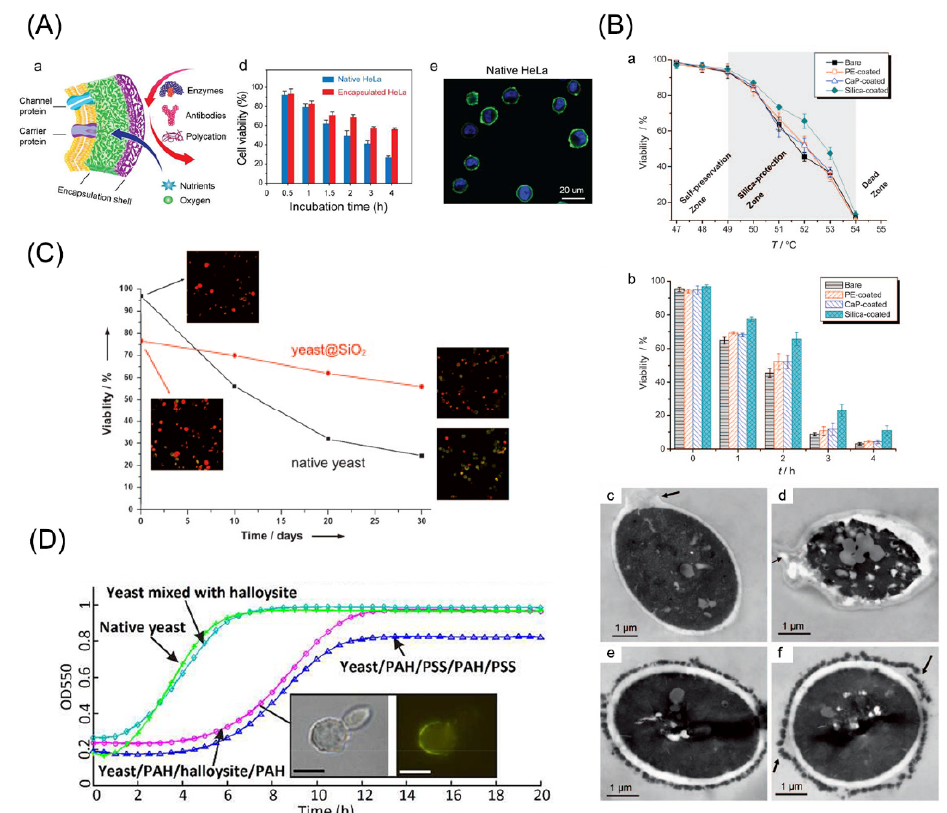
Figure 4. Functional regulation by cell encapsulation. ( A ) Yeasts can be protected from enzymes by encapsulation with gelatin and PEG. Adapted with permission [171]. Copyright 2017, Elsevier. ( B ) Thermo-resistance imposed by cell encapsulation. Adapted with permission [173]. Copyright 2010, John Wiley and Sons. ( C ) Encapsulated cells exhibited higher viability in water for a long term. Adapted with permission [174]. Copyright 2009, John Wiley and Sons. ( D ) Proliferation of yeast cells can be tuned by encapsulation. Adapted with permission [41]. Copyright 2013, Royal Society of Chemistry.